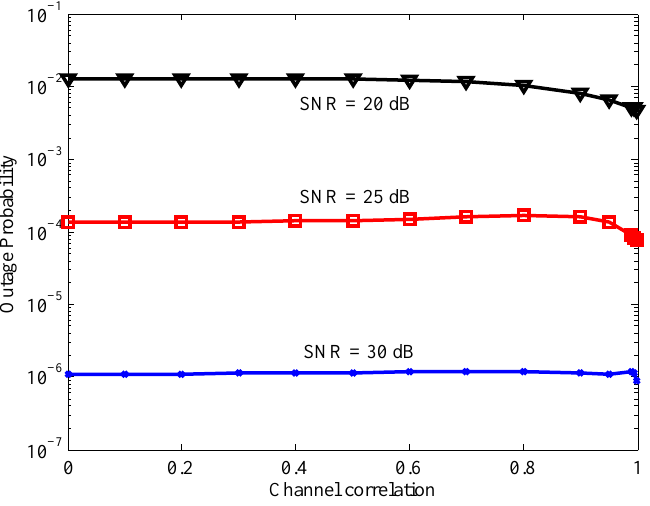
Figure 5. System outage probability versus average channel correlation with K =